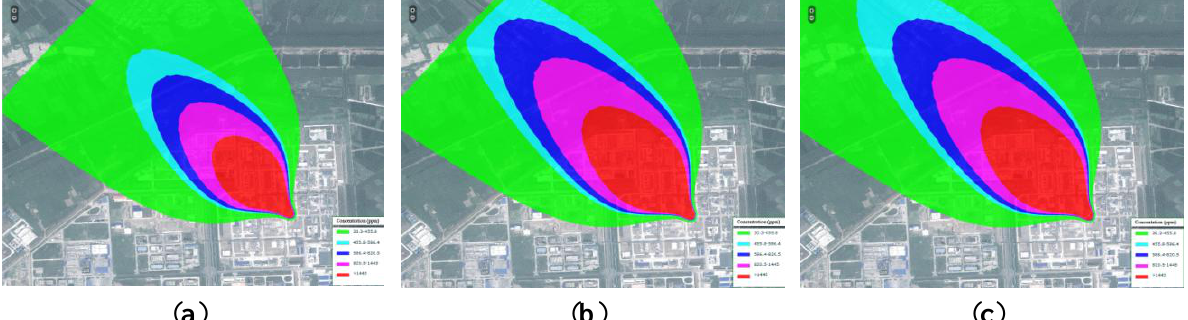
Figure 4. Time-series dynamic map for the leakage concentration field in the RS image (height 10 m). Images ( a ), ( b ), and ( c ) present the concentration field at the 5 min, 10 min, and 15 min, respectively, after the leakage